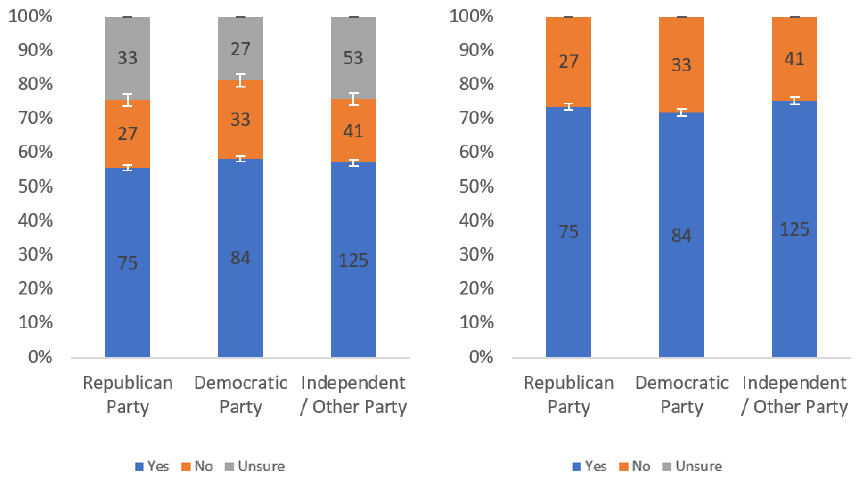
Figure 17. Responses regarding others’ willingness to review by party affiliation including ( left ) and excluding ( right ) unsure responses.